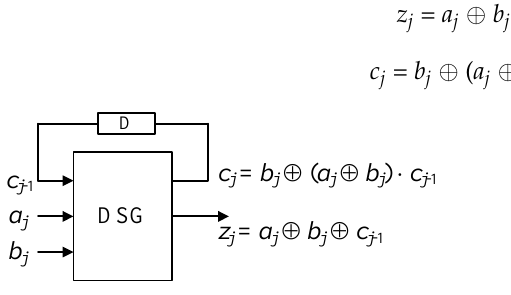
Figure 7. The Dawson’s summation generator.